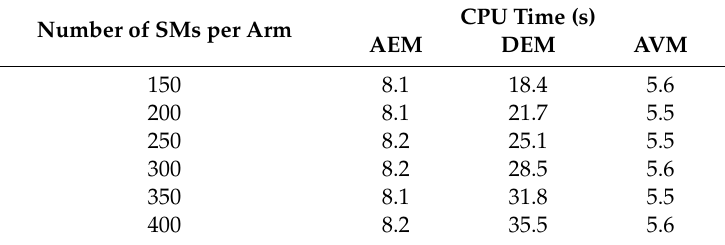
Table 3. Execution times for the three